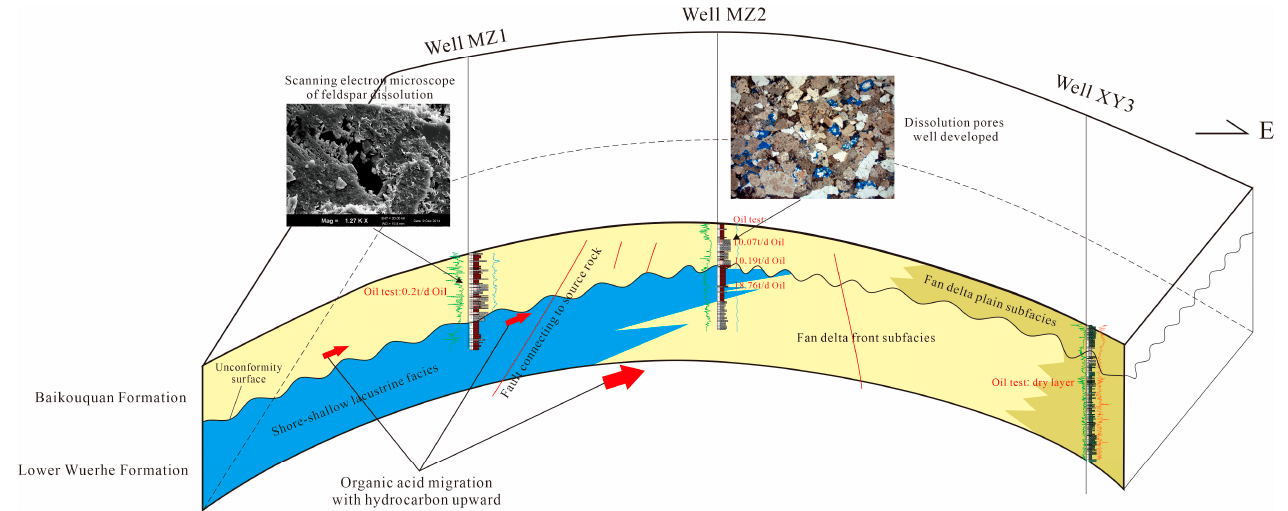
Figure 12. Relationship between diagenesis and hydrocarbon